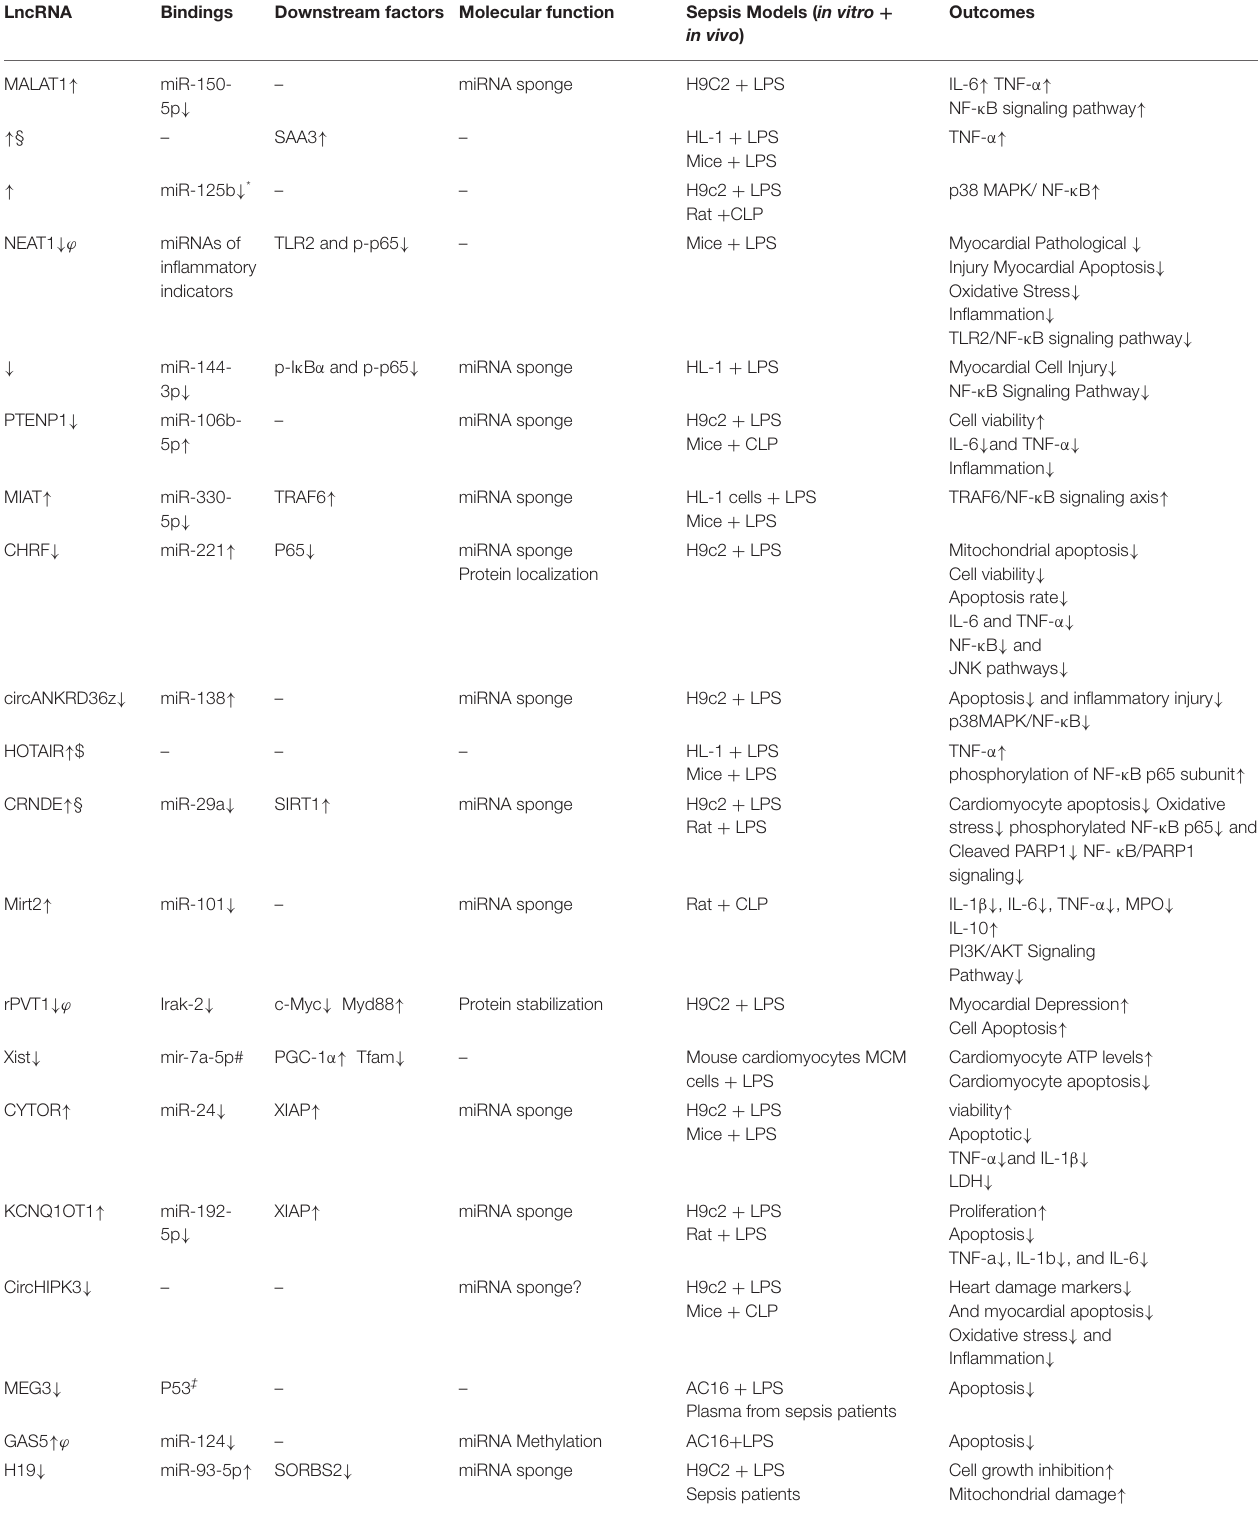
TABLE 1 | Direct evidence of lncRNAs in SICD. LncRNA Bindings Downstream factors Molecular function Sepsis Models ( in vitro +